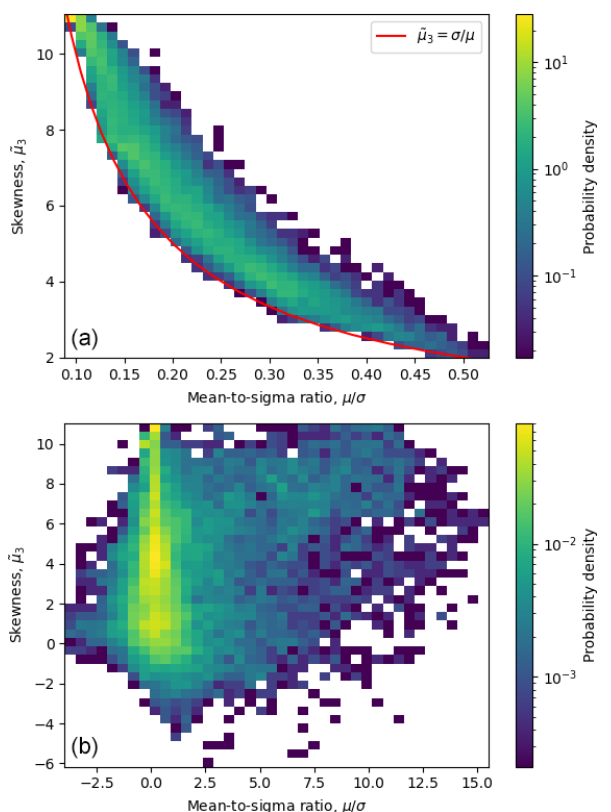
Figure 3. Two-dimensional histogram plot for the prior (a) and analysis (b) distributions showing the probability density for skew- ness ( ˜ µ 3 ) and mean-to-sigma ratio ( µ/σ ) values, where µ refers to ensemble mean and σ to standard deviation. Results correspond to the first assimilation cycle of the Raikoke experiment.